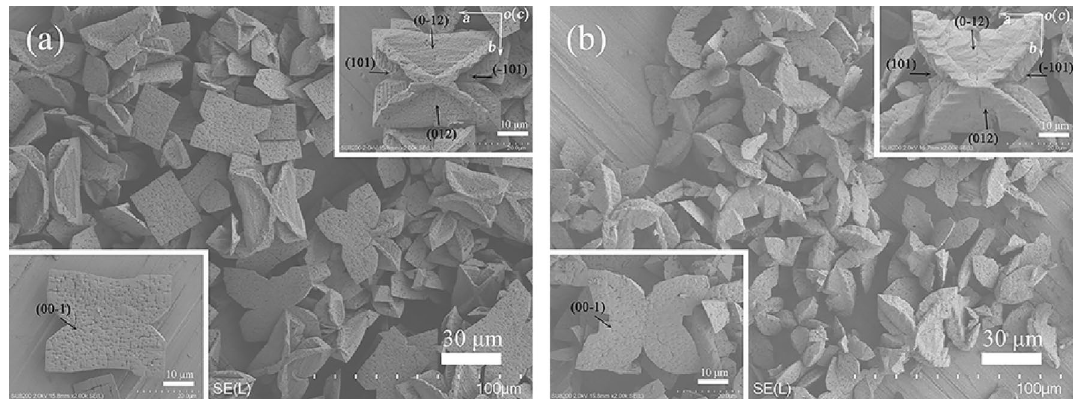
Figure 8. FESEM images of struvite biomimetically synthesized for 130 min in the presence of supernatant with adding 10 mmol/L phosphate and 3 mmol/L magnesium ions ( a ) or 7 mmol/L magnesium ions ( b